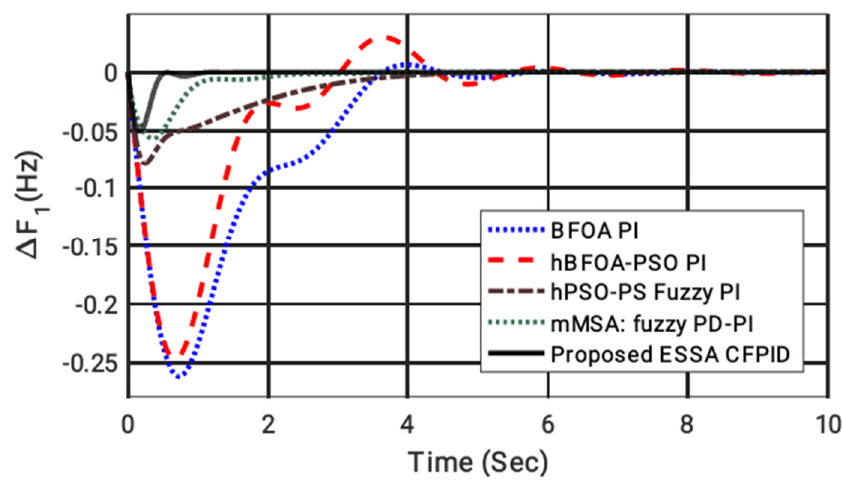
Figure 6. Frequency deviation of first area for 1st test system.